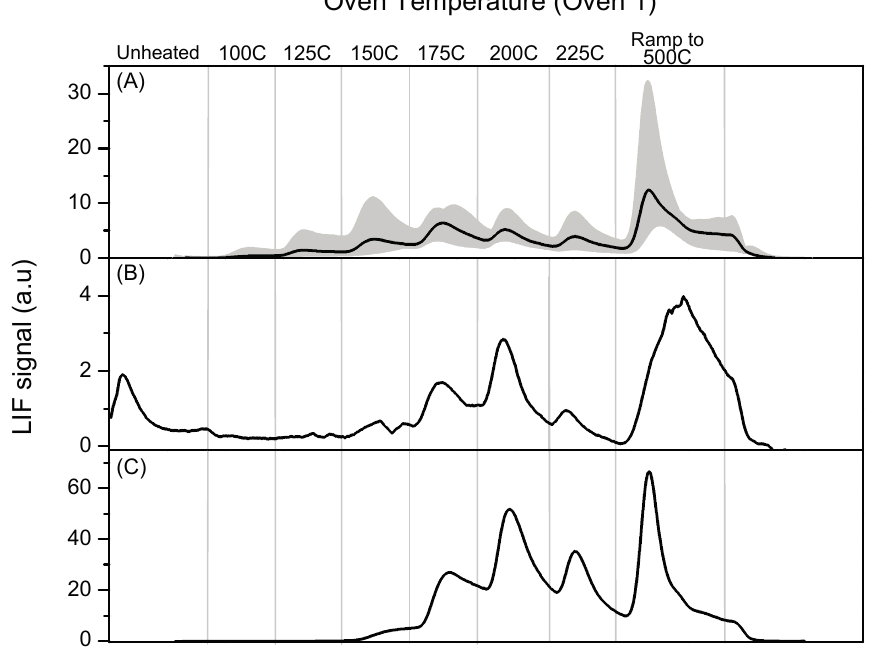
Figure 6. Panel ( A ): Calibration profile obtained from average of six PTD profiles using Oven 1 program for denuder loaded with pure HgCl . The grey shading spans the minimum 2 and maximum signals observed; Panel ( B ): Dissociation profiles obtained using Oven 1 program for “close-in” airship sample collected 28 February 2008; Panel ( C ): Dissociation profiles obtained using Oven 1 program for stack sample collected 29 February